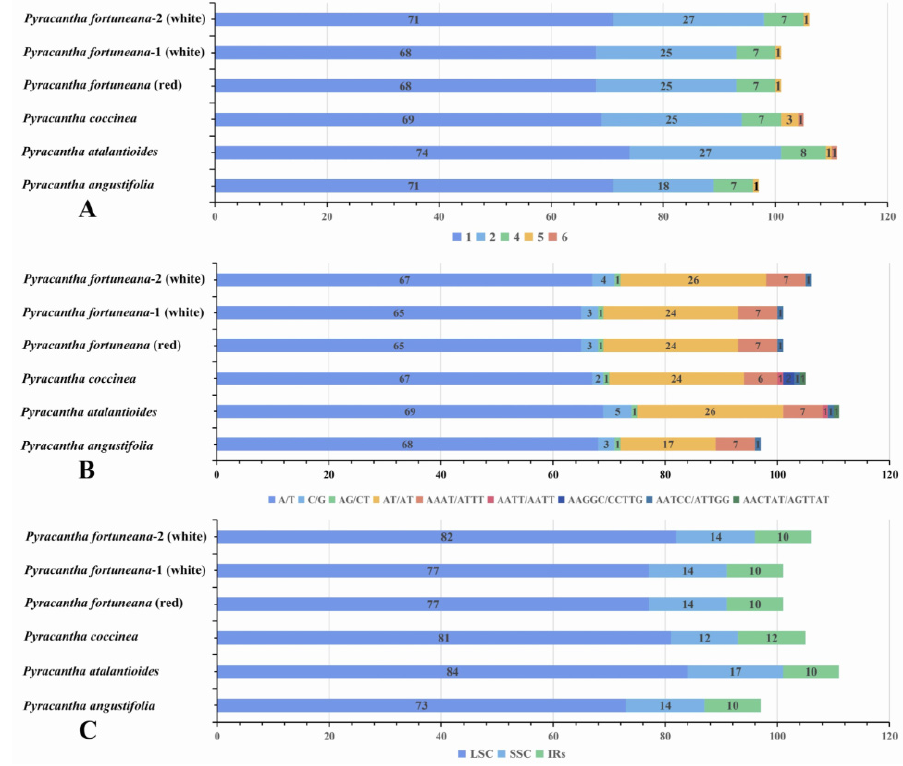
Figure 6. Analyses of SSRs in six Pyracantha chloroplast genomes. ( A ) Frequency of SSR types. ( B ) Frequency of different SSR units. ( C ) Frequency of SSRs in LSC, SSC, and IR regions.